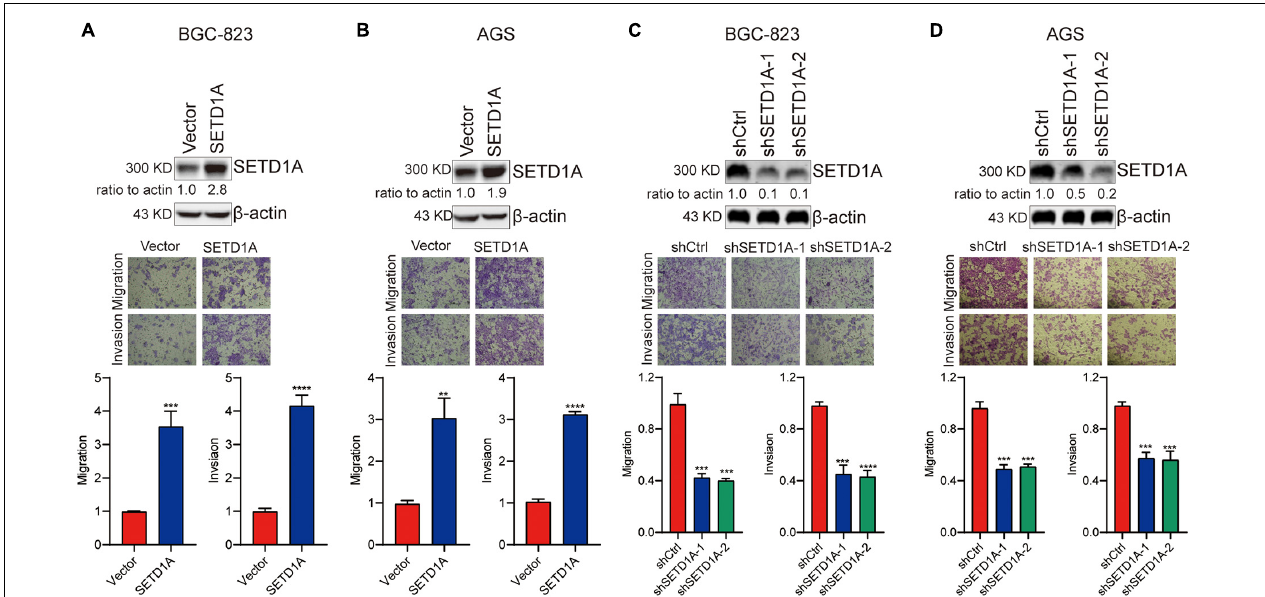
FIGURE 1 | SETD1A promotes GC cell migration and invasion. (A,B) Overexpression of SETD1A increases BGC-823 (A) and AGS (B) cell migration and invasion. Data from three replicates are shown as the means ± SD. ** p < 0.01, *** p < 0.001, **** p < 0.0001 by Student’s t -test. (C,D) Downregulation of SETD1A decreases BGC-823 (C) and AGS (D) cell migration and invasion. Data from three replicates are shown as the means ± SD. *** p < 0.001, **** p < 0.0001 by Student’s t